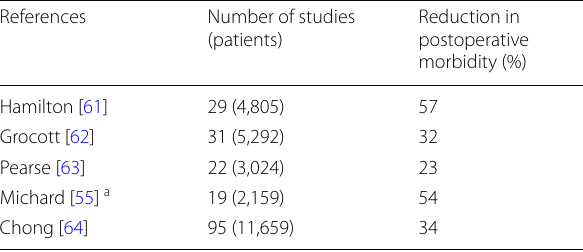
a Non-calibrated pulse contour analysis